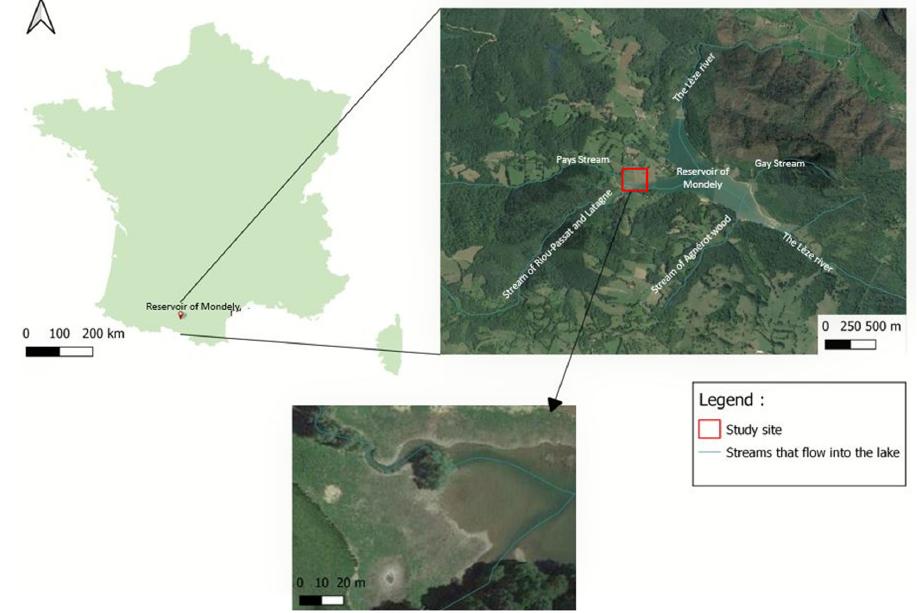
Figure 1. Map of the Mondély reservoir showing the location of the study site (red rectangle). The dam is visible at the upper side of the reservoir.